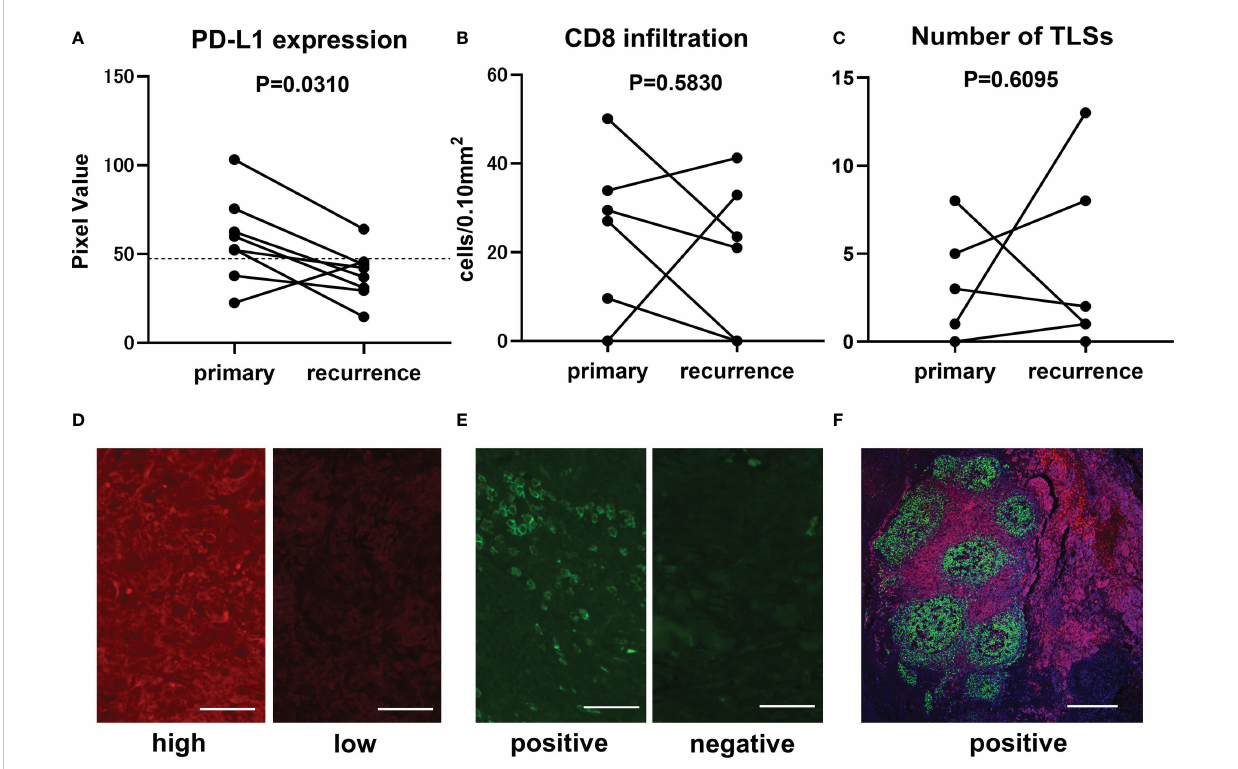
FIGURE 3 Comparison of immuno fl uorescence staining results between primary and recurrent lesions in CAS. Transitional change of PD-L1 expression from primary lesion to recurrent lesion is represented in the graph (n=8, paired t-test, p-value=0.0310). Mean pixel value of PD-L1 expression intensity of 62 samples was 47.4 and is indicated by broken line (A) . Transitional change of in fi ltrating CD8-positive cells (n=8, paired t-test, p-value=0.5830). The number of counted CD8-positive cells converted per 0.10 mm 2 fi eld area (B) . Transitional change of the number of TLSs in a section (n=8, paired t-test, p-value=0.6095) (C) . Representative immuno fl uorescence staining in samples with high (left panel, PV=103.2) and low (right panel, PV=37.1) PD-L1 expression. Scale bar, 50µm (D) . Representative immuno fl uorescence staining in samples with positive (left panel, 50.12